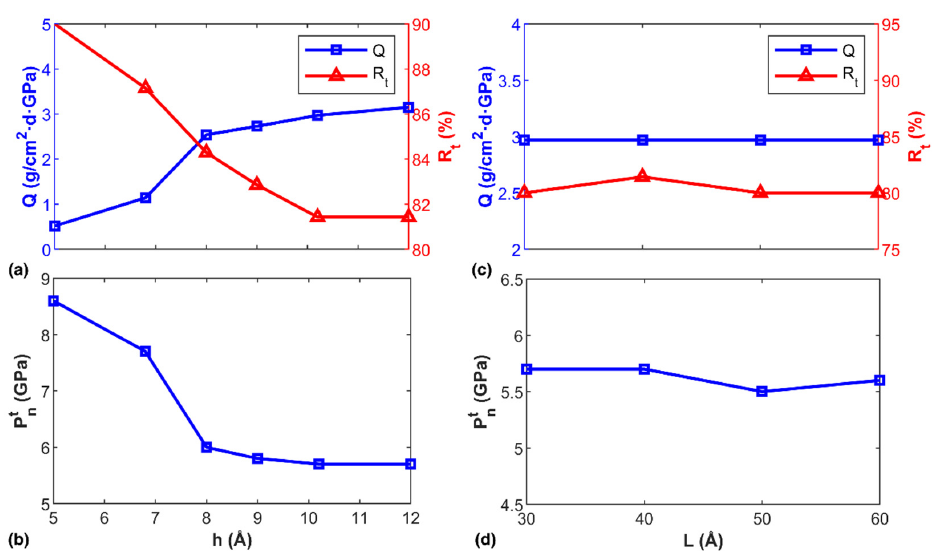
Figure 6. Transportation properties of NaCl solution in diamond channels with different heights and lengths. ( a ) The water flux and ion retention rate as a function of the channel height; and ( b ) The transition pressure as a function of the channel height; ( c ) The water flux and ion retention rate as a function of the channel length; and ( d ) The transition pressure as a function of the channel length.